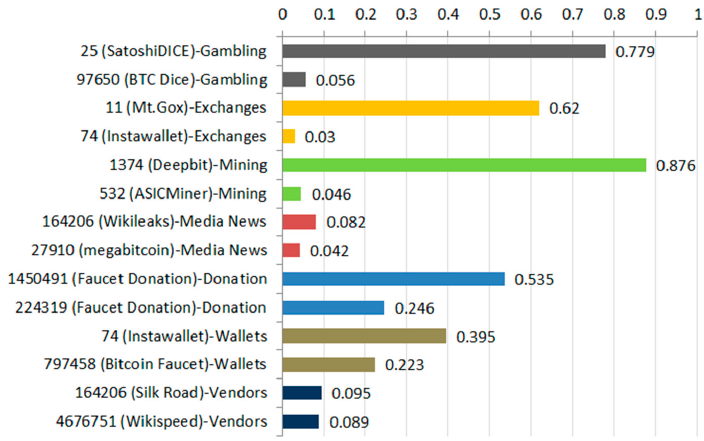
Figure 28. Degree Centrality per Business Category.